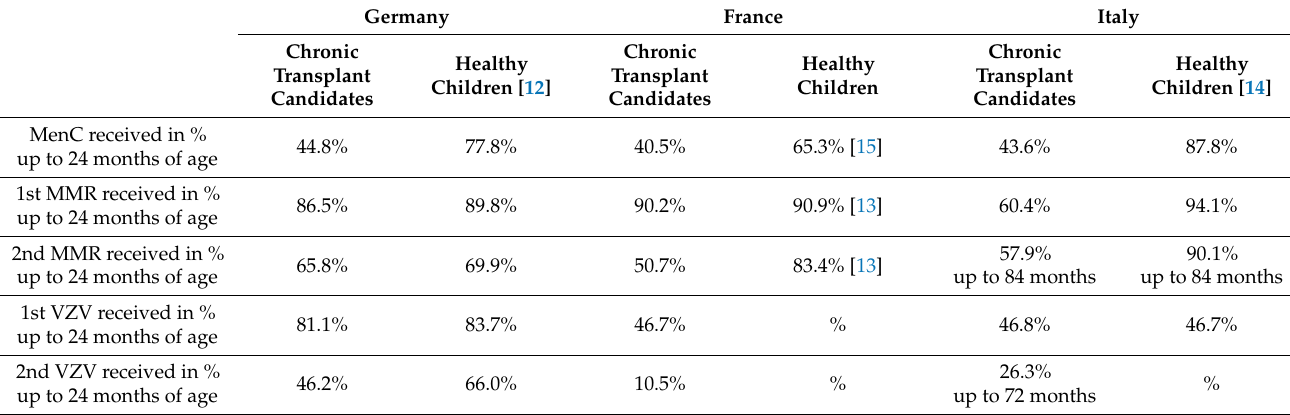
Table 3. Country-specific vaccination of eligible children with chronic liver disease and healthy controls. Data on healthy children was taken from national reference